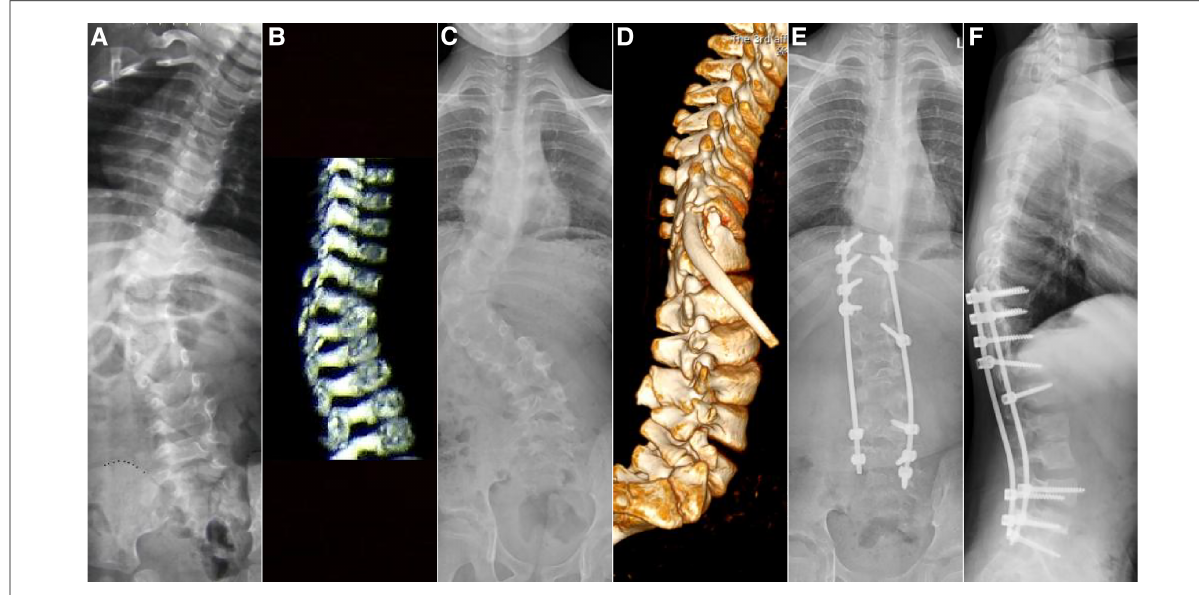
FIGURE 4 Case 15, female, 11 months old. Preoperative orthogonal x-ray ( A ) and lateral computer tomography ( B ) showing the right hemivertebrae of T11. Intraoperative hemivertebra resection was performed via the posterior approach. After 9 years of follow-up, orthogonal x-ray ( C ) and orthogonal computer tomography ( D ) showed local pseudoarticular formation and worsening deformity, and a second internal fi xation revision surgery was performed. Post-revision orthogonal ( E ) and lateral ( F ) x-ray showed good correction of the deformity in the coronal and sagittal